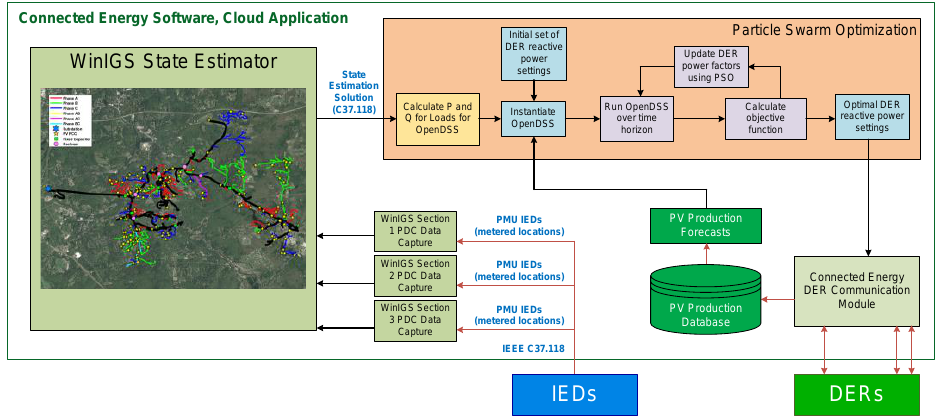
Figure 2. Block Diagram of the Information Flow in the PSO Optimization Method.